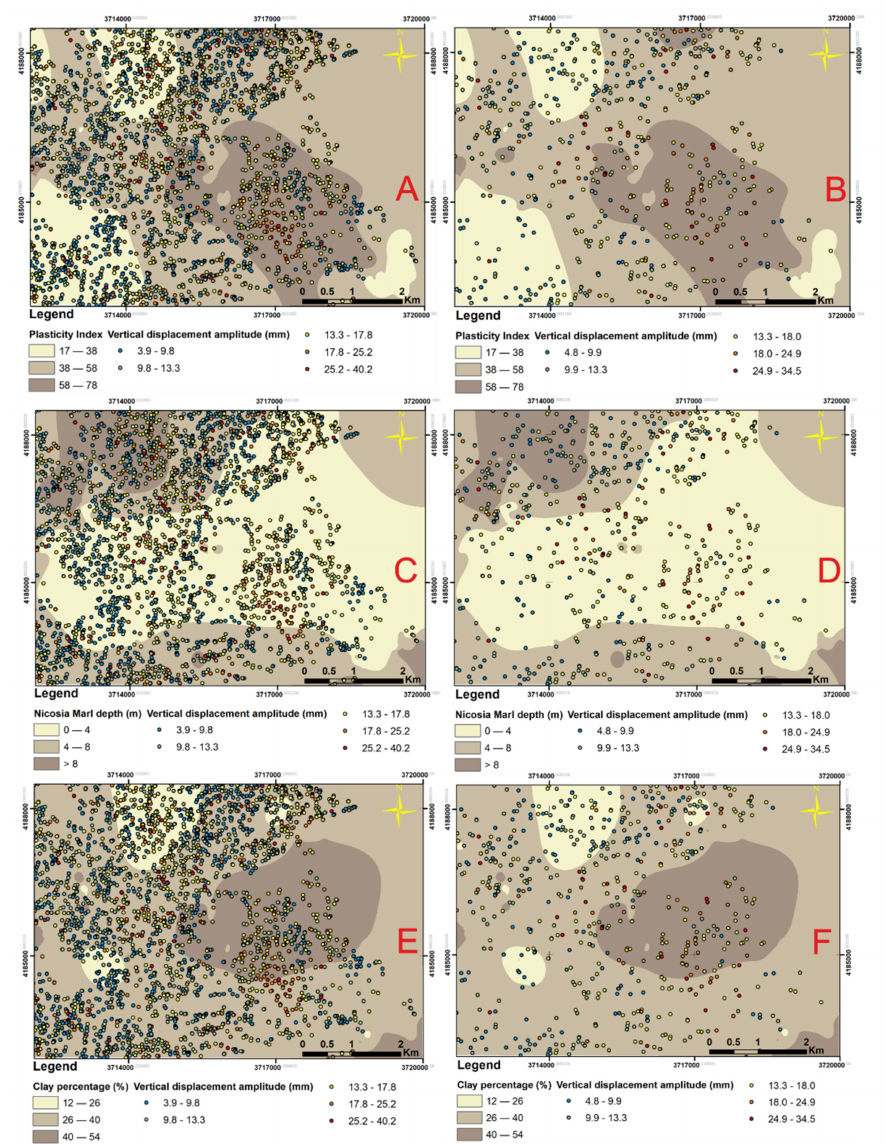
Figure 6. Spatial distribution of the vertical displacement amplitude along with the factors which strongly affect the phenomenon: ( A , C , E ) PS points, ( B , D , F ) free field PS